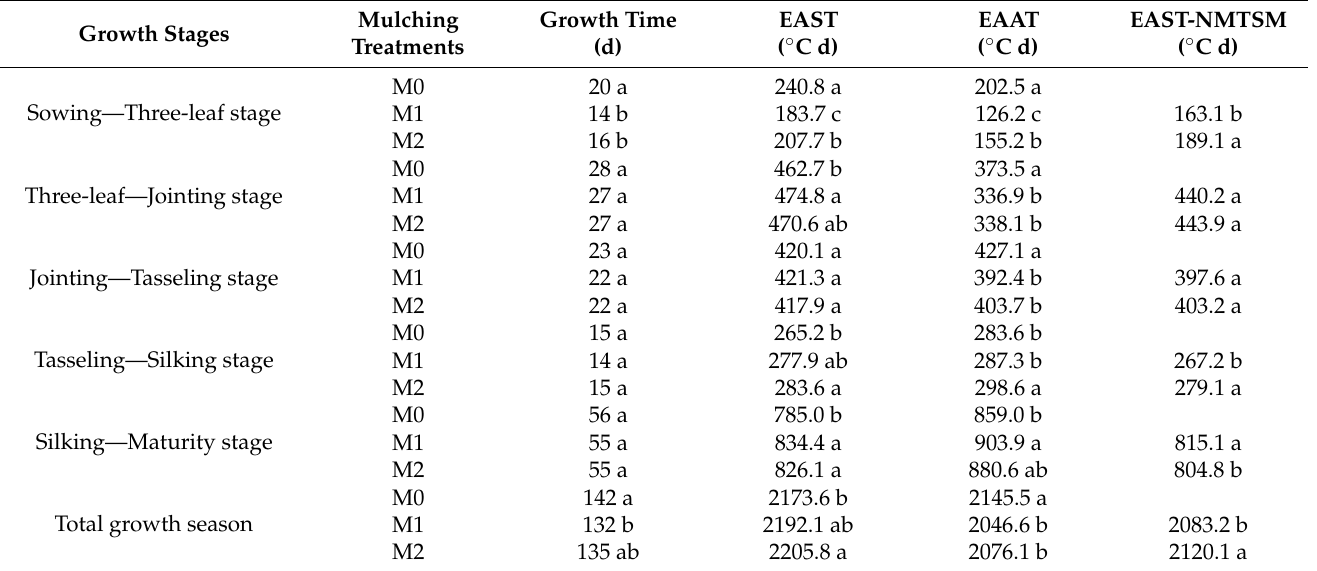
Table 2. Influence of different film mulching treatments on maize developmental progress, the effective accumulated soil temperature (EAST), the effective accumulated air temperature (EAAT) and the effective accumulated soil temperature under no mulching when the time is the same as plastic film mulching (EAST-NMTSM) in 2017. Different letters are significantly different at the p < 0.05 probability